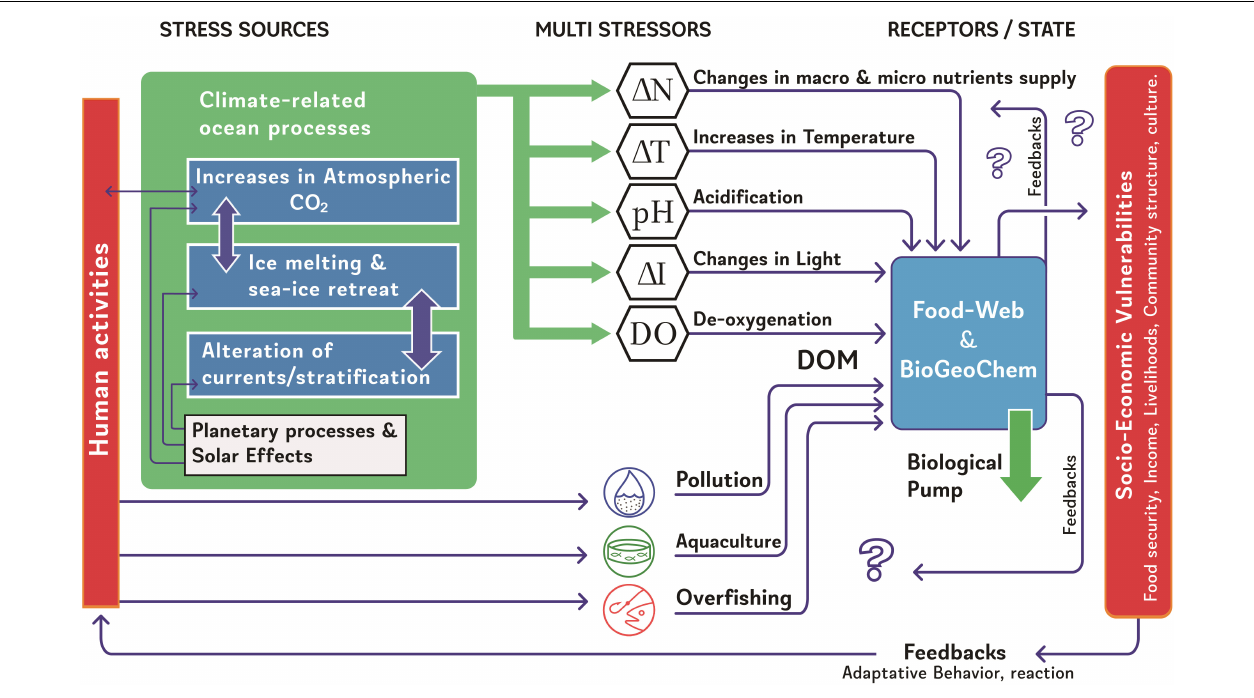
FIGURE 1 | Conceptual flow diagram of a coastal marine ecosystem, showing complex atmosphere–ocean interactions through: (i) a variety of different actual stress sources from Human, Atmosphere, Cryosphere, and Ocean main processes, (ii) the individual and combined effects of environmental stressors, and (iii) their main changes in outputs acting on the Biological Carbon Pump and marine food web chains. In the Subantarctic Patagonian system, most of the actual and potential stressors are acting in a thin, two-layer water column that is heavily stratified by salinity near the surface. Changes in the food web compartment can lead to decreased or increased efficiency of the Biological Pump, a key aspect on which efforts must be focused in the near future. The diagram includes a series of climatic and non-climatic stressors (e.g., overfishing, aquaculture) that might eventually affect the food web and, subsequently, the Biological Pump; however, the concomitant positive/negative feedbacks to societal coastal related processes remain unknown (Main conceptual figure from the Ocean Certain EU Program, with permission of Dr. Murat V. Ardelan).